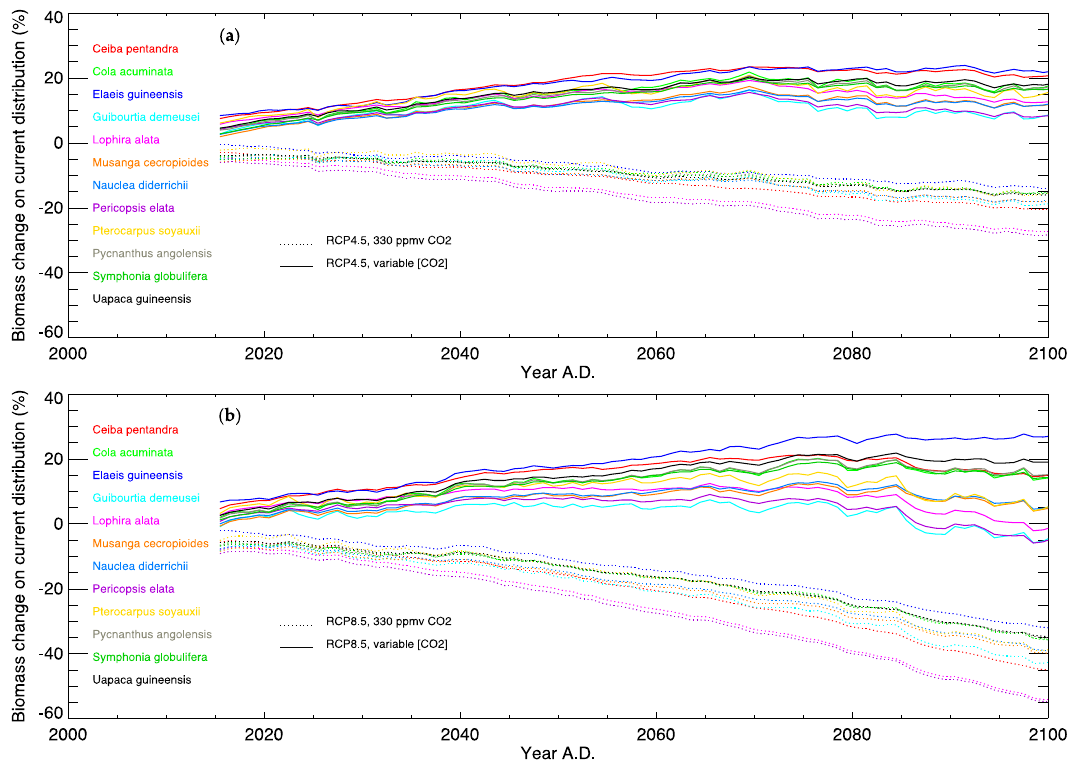
Figure 8. Species biomass change on current distribution over time (from 2015 to 2100) compared to mean biomass for the reference 1980–1999 period. The values correspond to the ensemble mean of the results obtained with the seven climate projections under ( a ) the RCP4.5 and ( b ) RCP8.5 scenarios, and two CO 2 configurations assuming respectively a CO 2 constant [330] (dotted line) and a CO 2 variable [var] (solid line), and species-specific morpho-physiological traits.